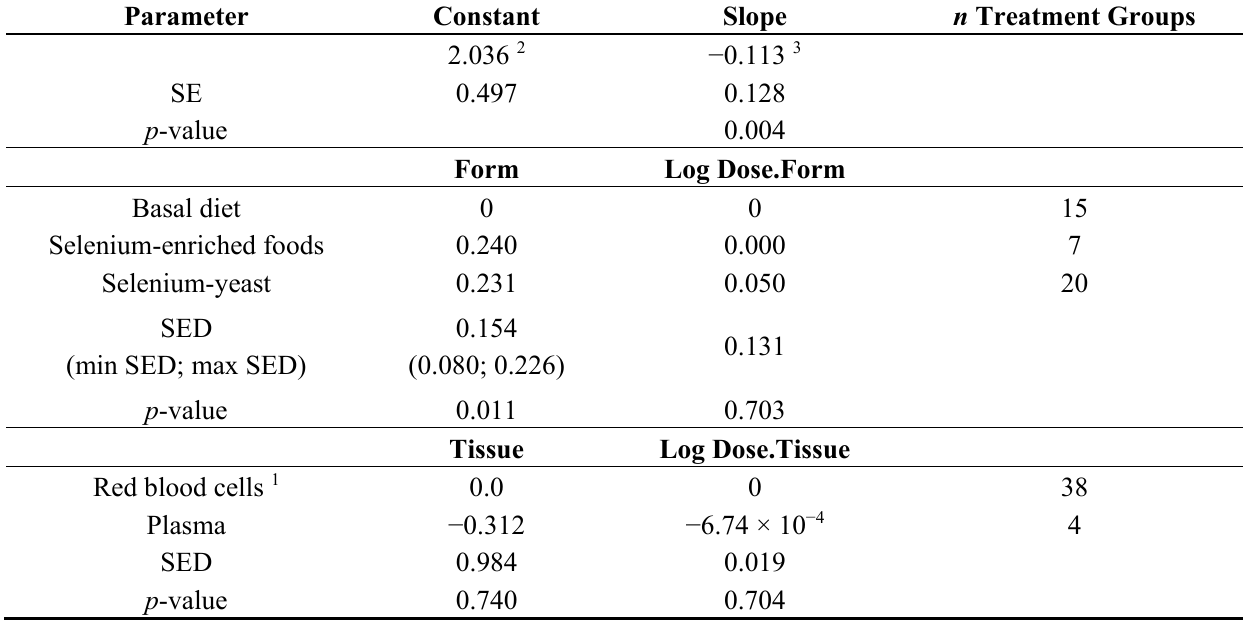
Table 5. Table of effects for humans showing the relationship between selenium intake and Glutathione Peroxidase (GPx) activity. Dose response relationships were determined using the equation: Log GPx activity = (Constant + Form + Tissue) + (Log Dose.Form + Log Dose.Tissue). Model coefficients or effects, and the average standard error of difference (SED) between pairs of effects (with the minimum and maximum SEDs where appropriate) are reported. Constant Slope n Treatment Groups 2.036 2 −0.113 3 0.497 0.128